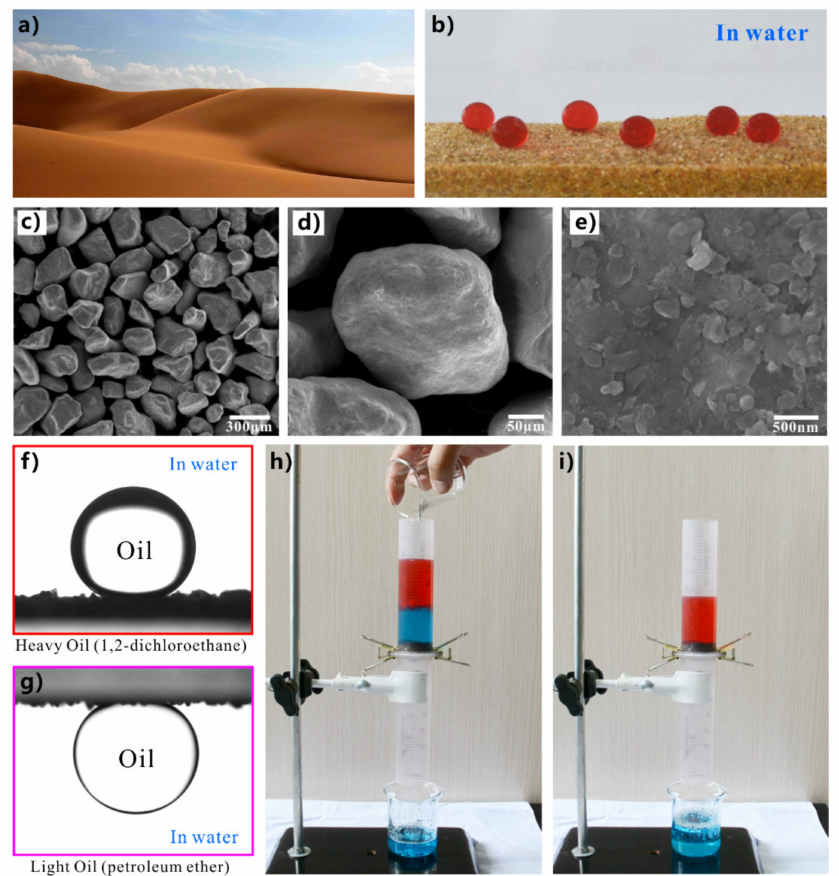
Figure 16. Simply separating the oil/water mixture by prewetted sand layer. ( a ) Desert. ( b ) Drops of heavy oil on the sand in water. ( c ) SEM image of a sand layer composed of a large number of sand particles. ( d ) Morphology of a sand grain. ( e ) Surface microstructure of a sand grain. ( f ) Heavy and ( g ) light oil droplets on the sand layer underwater. ( h , i ) Separating the oil/water mixture by using the prewetted sand layer: ( h ) pouring the mixture of water (blue color) and oil (petroleum ether, red color) onto the sand layer and ( i ) after separation. Reprinted with permission from ref. [263]. Copyright 2016, WILEY-VCH Verlag GmbH & Co.